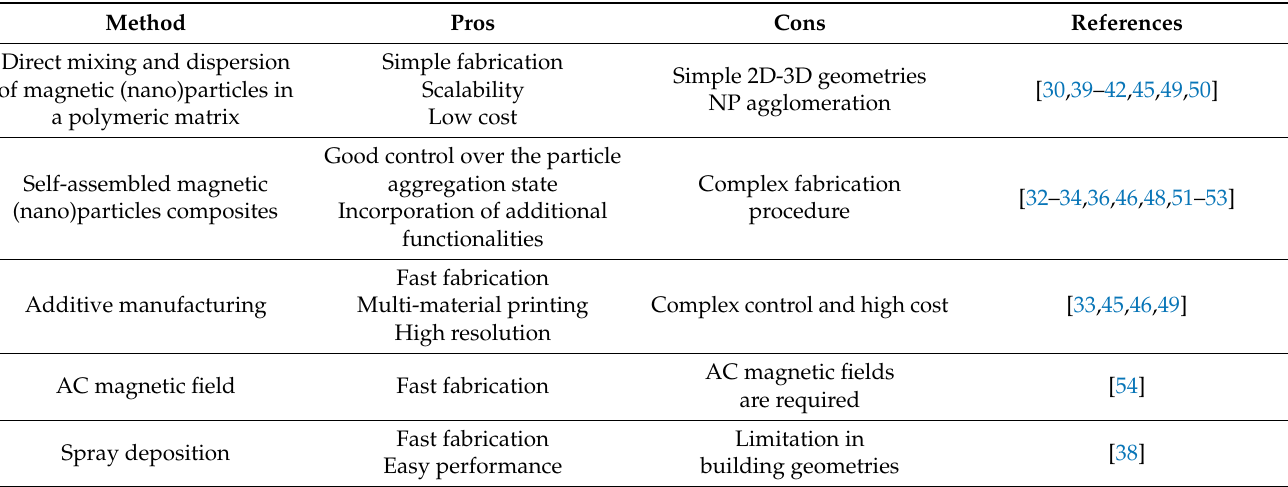
Table 1. The most utilized fabrication methods for magnetic self-healing composites together with their pros and